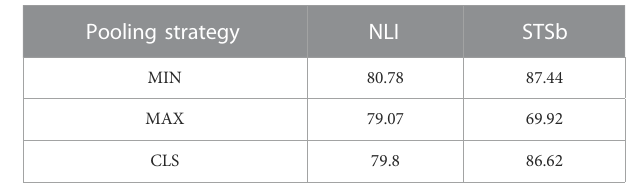
TABLE 2 Pooling strategy